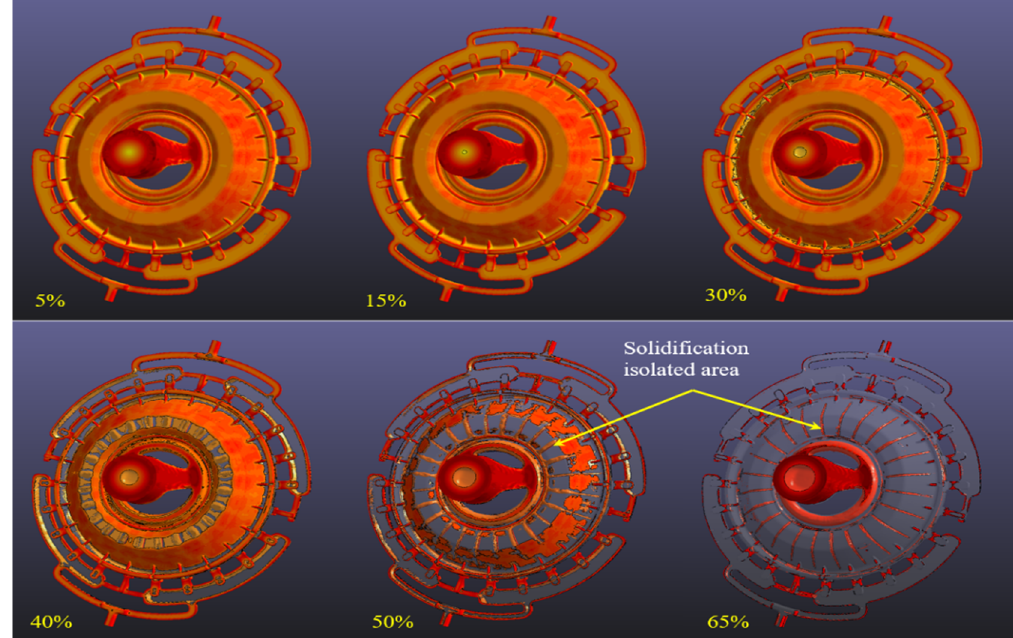
Figure 9. Simulation results of the solidification for case 3.